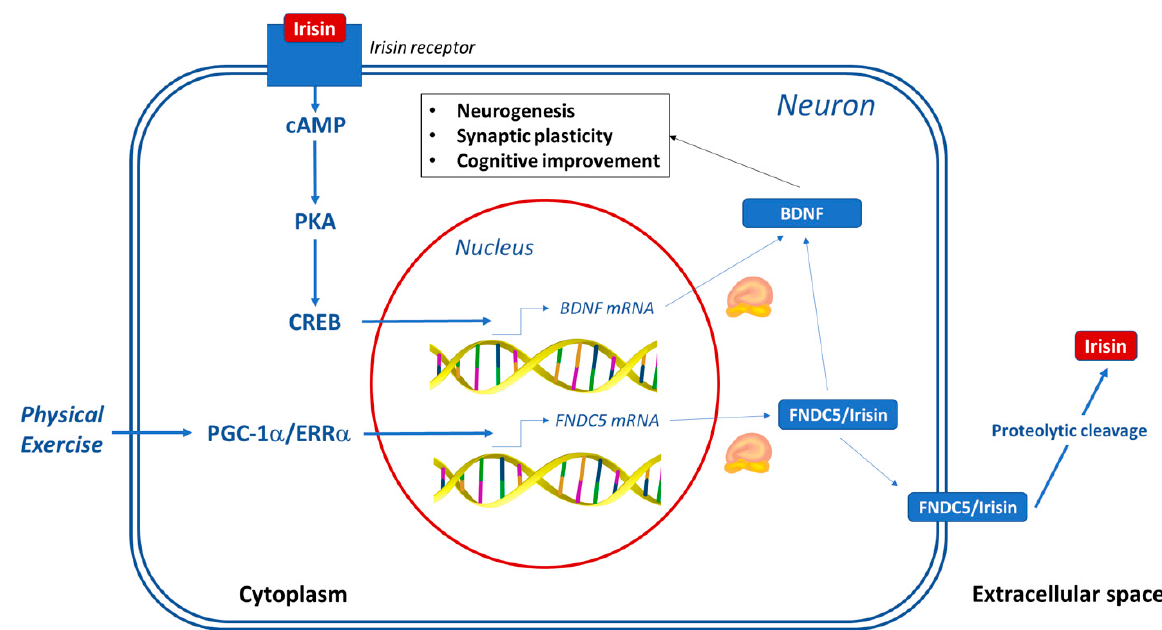
Figure 3. FNDC5/Irisin signaling in the brain. Schematic representation of irisin action on neuron. Irisin stimulates synaptic plasticity, neurogenesis and cognitive improvement by induction of expression of brain-derived neurotrophic factor (BDNF). Physical exercise further induces brain FNDC5 and irisin release. cAMP: cyclic adenosine monophosphate; CREB: cAMP response element-binding protein; ERR α : Estrogen-related receptor α ; FNDC5: Fibronectin type III domain containing 5; PGC-1 α : PPAR γ coactivator 1 α ; PKA: cAMP-dependent protein kinase.